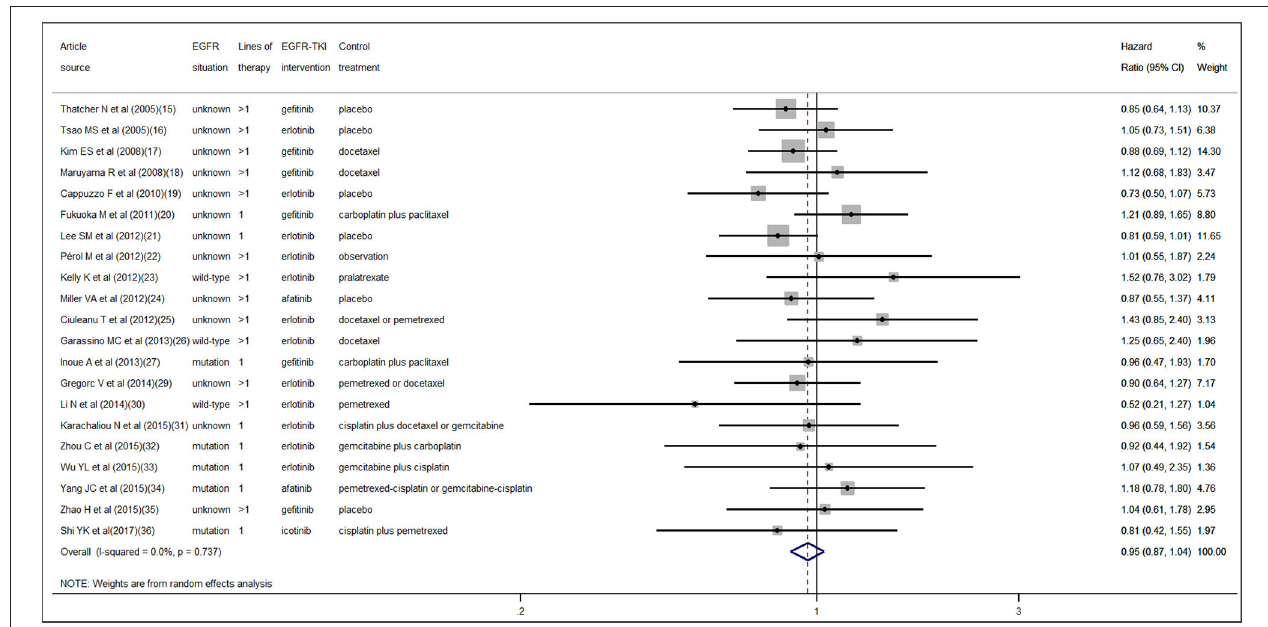
FIGURE 2 | Forest plot of the pooled analysis of the interaction hazard ratios of sex.